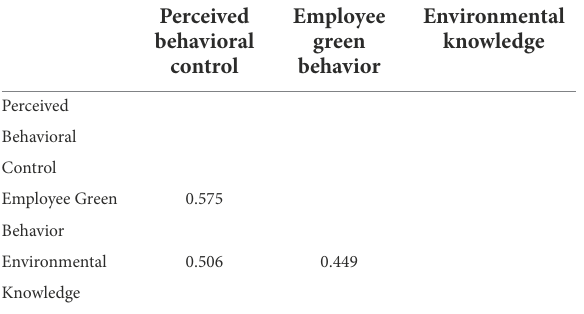
TABLE 4 Heterotrait-Monotrait Ratio (HTMT).